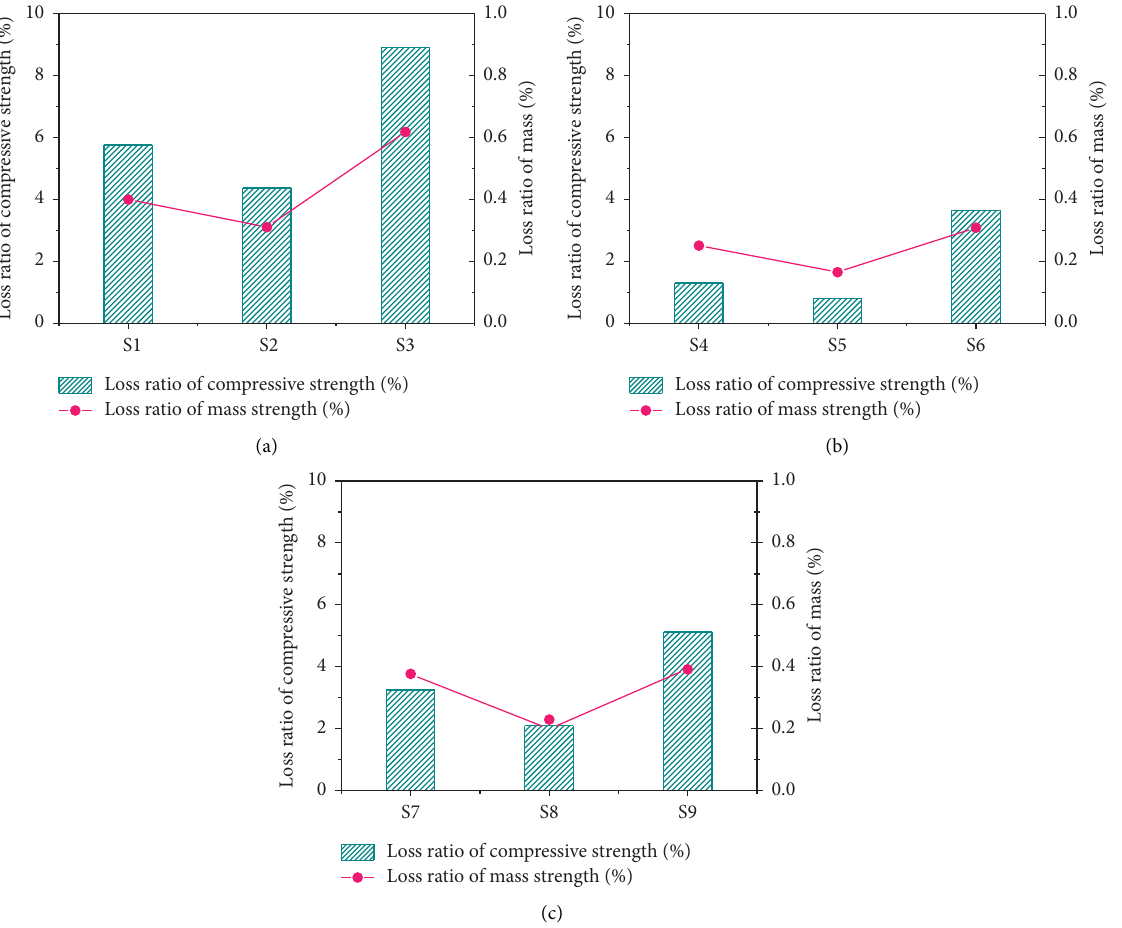
Figure 7: Compressive strength and mass loss rate of HPC with different mineral admixtures. (a) Fly ash; (b) CFBC ash; (c) CFBC